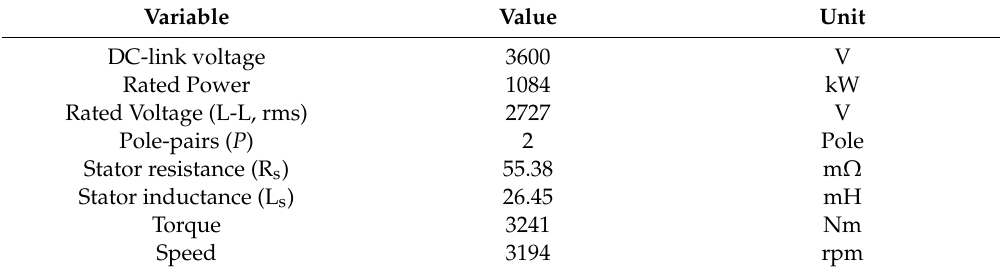
Table 2. Specifications of the induction motor at base speed ω base (extended full flux range design).